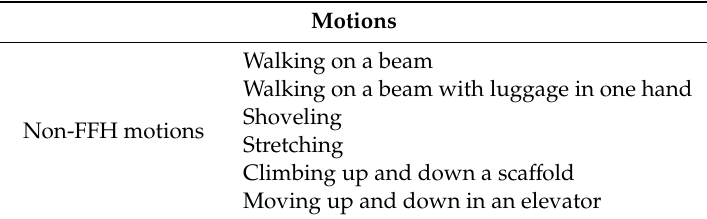
Table 2. List of additional motions in Experiment 2.